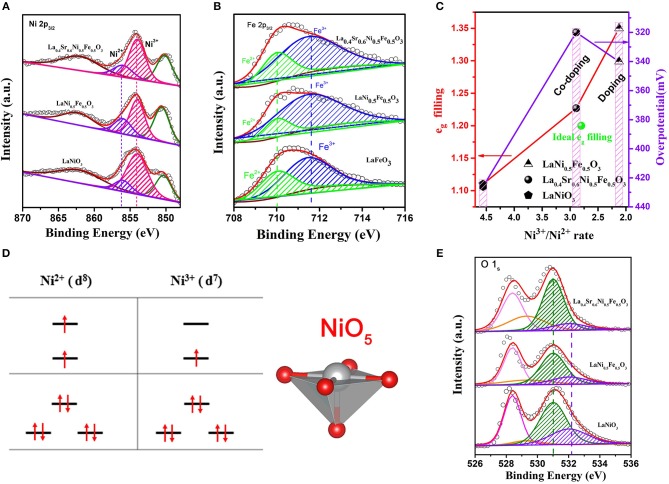
(A) Ni: 2p3/2, (B) Fe 2p3/2, and (E) O 1s spectra of LaNiO3, LaNi0.5Fe0.5O3, La0.4Sr0.6Ni0.5Fe0.5O3, and LaFeO3 perovskite oxides; The eg orbital filling of perovskites. (C)
eg filling and OER activity as a function of Ni3+/Ni2+ rate; The green dot only represents the ideal eg filling; (D) Electronic configuration and relevant metal orbitals of Ni2+ and Ni3+ for a NiO5 configuration.